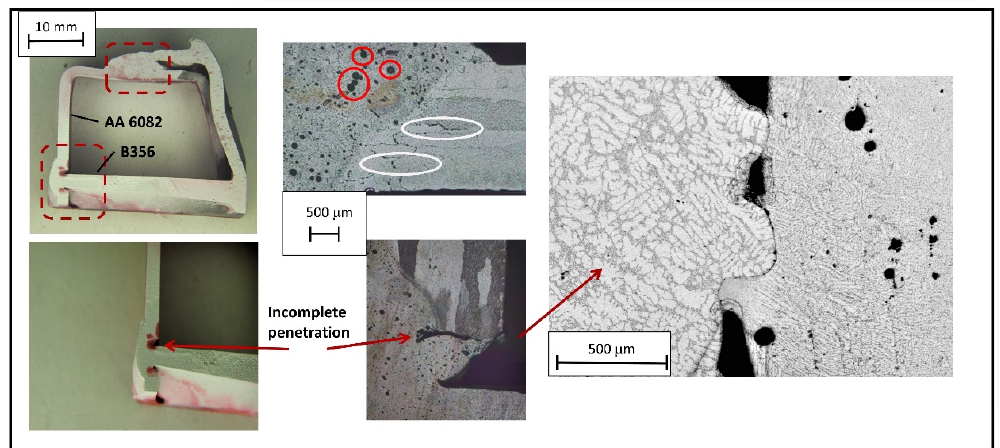
Figure 4. Defects and microstructures of MIG frame joints. E-C combination.